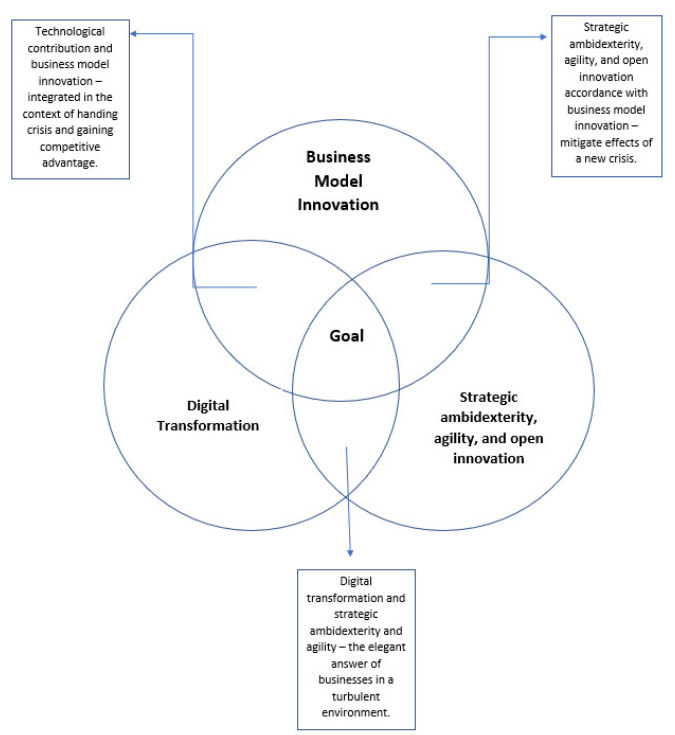
Figure 7 . New business model innovation for SMEs. Source: Own elaboration. Figure 7. New business model innovation for SMEs. Source: Own